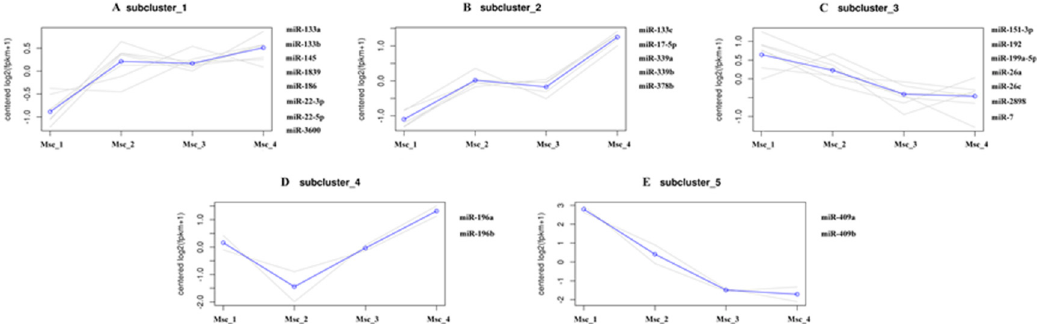
Figure 4. K-means clustering of ED miRNAs. ( A ), ( B ), ( D ): The expression levels of miRNAs increased gradually after adolescence. ( C ), ( E ): The expression levels of miRNAs decreased gradually after adolescence.